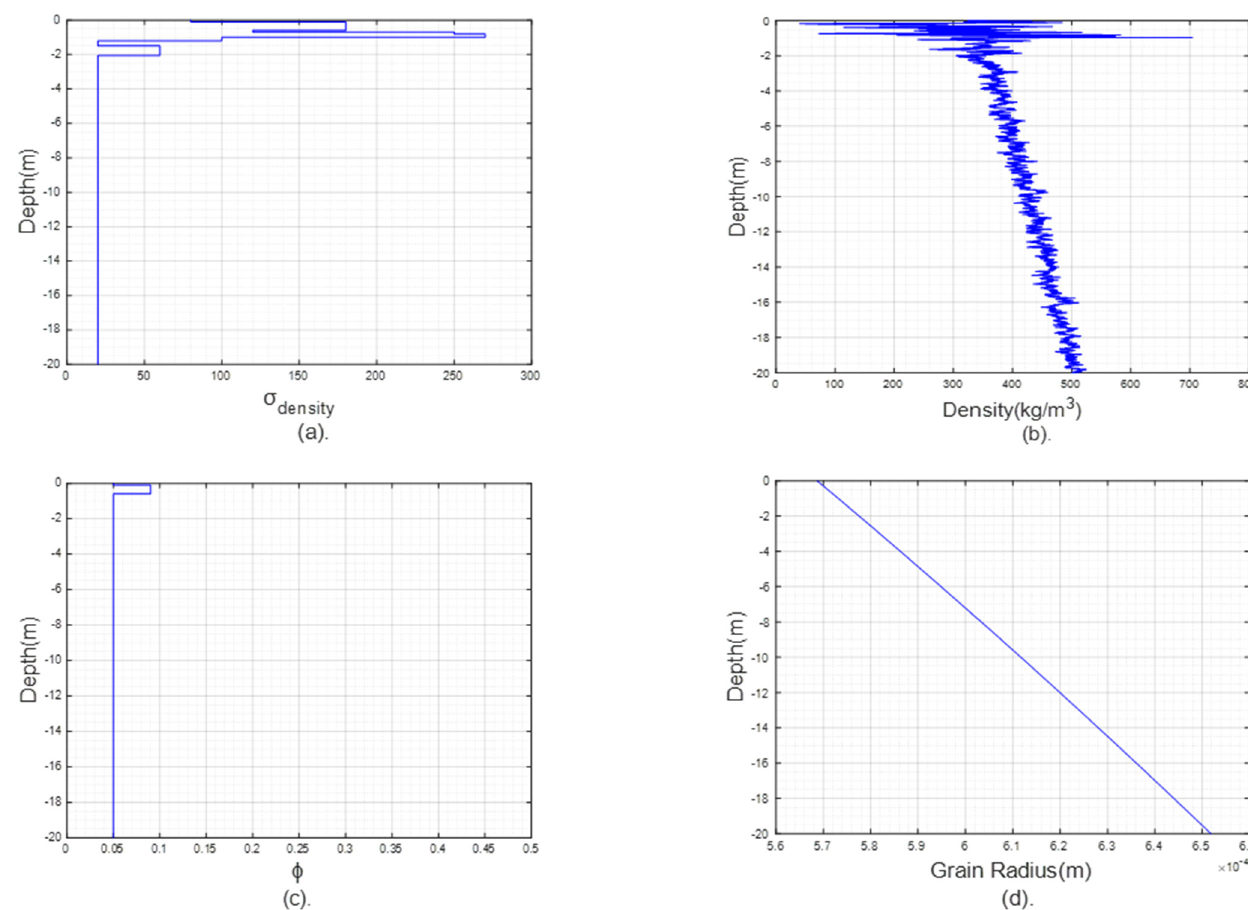
Figure 12. ( a ) Standard deviation of the firn density fluctuations, 𝜎 (cid:3031)(cid:3032)(cid:3041)(cid:3046)(cid:3036)(cid:3047)(cid:3052) (𝑧) ; ( b ) the resulting firn